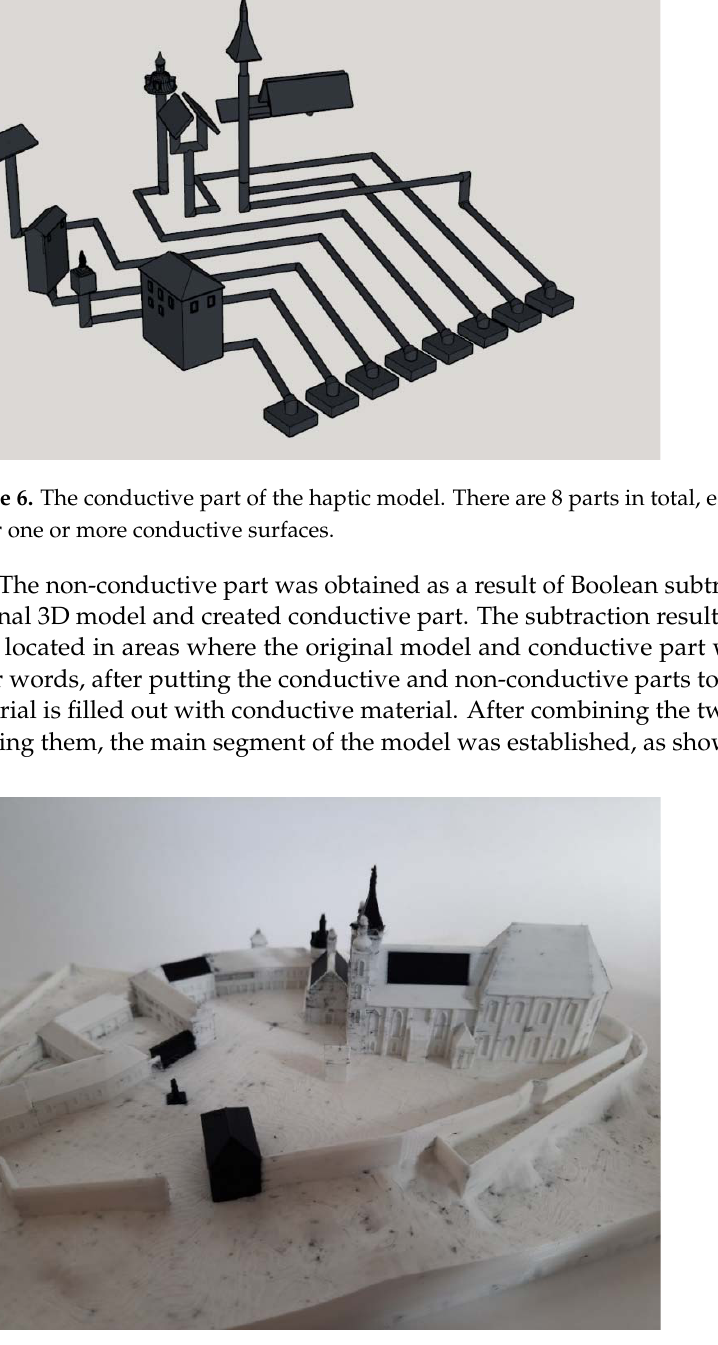
Figure 5. The original state of the 3D model before any modifications (e.g., adding the conductive part) were made.